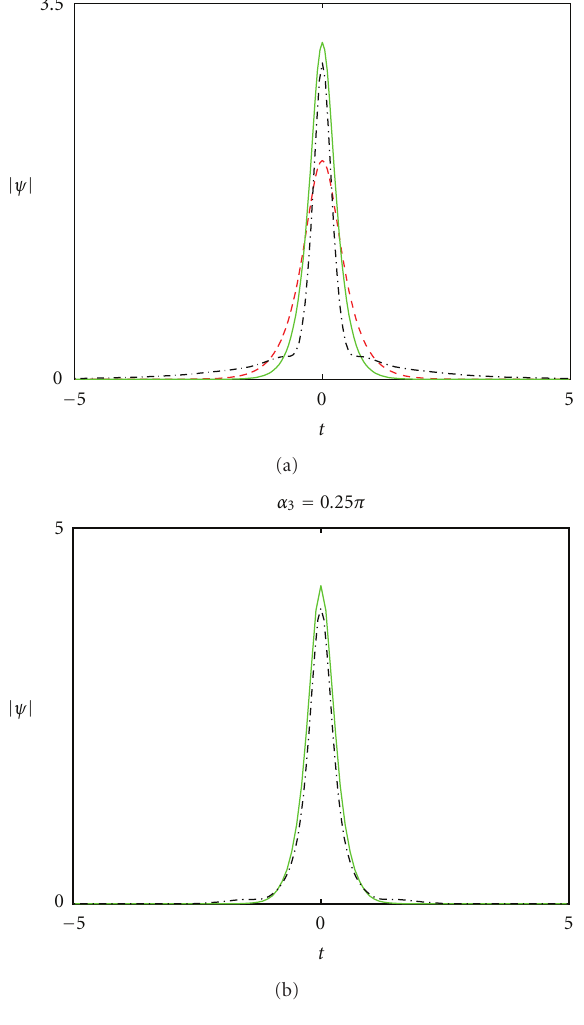
Figure 13: Stable single-pulse solution with the largest possible am- plitude of the full governing system (black dash-dot curve), CQGLE (red dashed curve), and SGLE (green solid curve) at α 3 = 0 . 2 π (a) and α 3 = 0 . 25 π (b). The rest of the parameters are D = 0 . 4, τ = 0 . 1, e 0 = 1, Γ = 0 . 1, α 1 = 0, α 2 = 0 . 49 π , α p = 0 . 45 π , and K = 0 . 1. The initial conditions are ψ (0, t ) = 0 . 5 sech t (from [29], 2011,